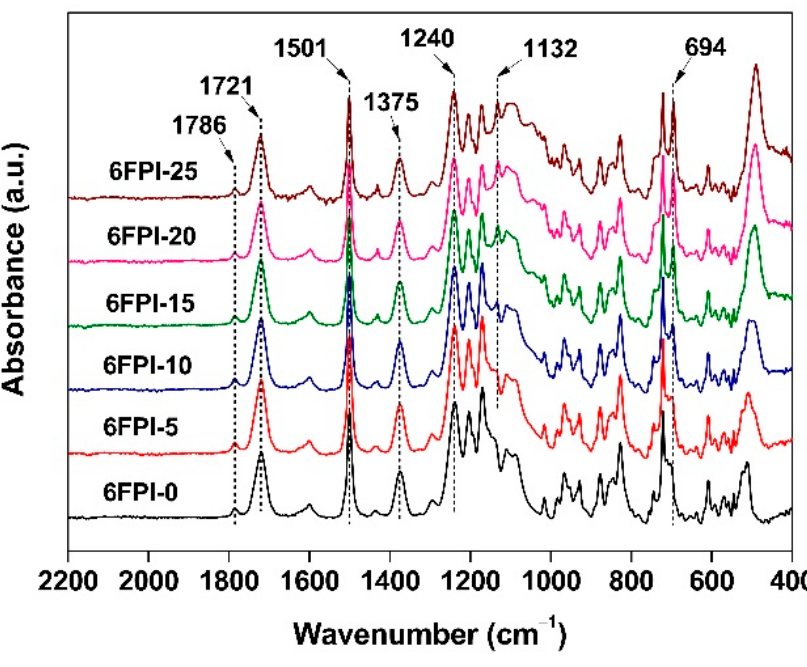
Figure 4. ATR-FTIR spectra of 6FPI-POSS composite films.